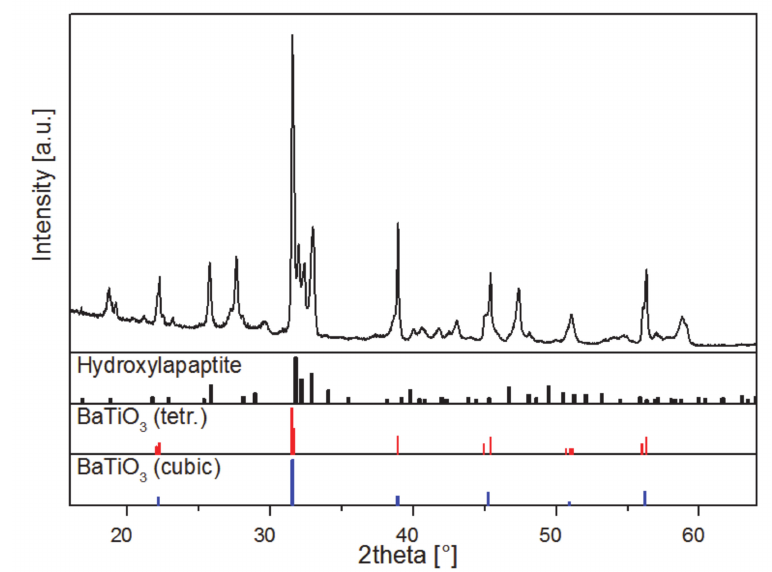
Figure 7. Powder di ff raction pattern of 3D printed and sintered BaTiO 3 / HA sca ff old and reference data: pdf 01-076-8436 (ICDD, 2016, hydroxyapatite), 01-081-8524 (ICDD, 2016, BaTiO 3 , tetragonal), and 01-081-8527 (ICDD, 2016, BaTiO 3 , cubic), respectively. Reference data is shown in relative intensities. Cu K α 2 radiation has been removed arithmetically for